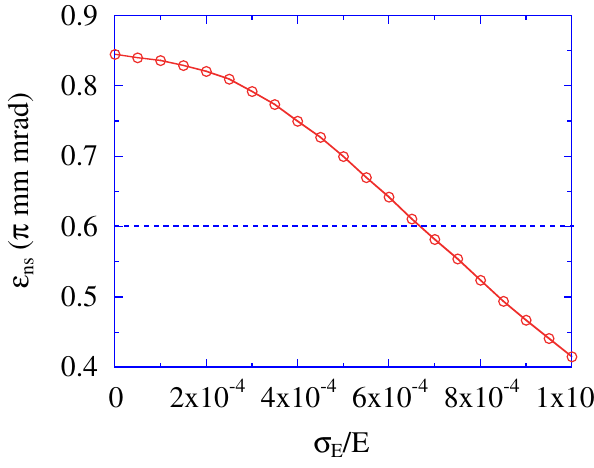
=E to reproduce and (cid:8) E ns